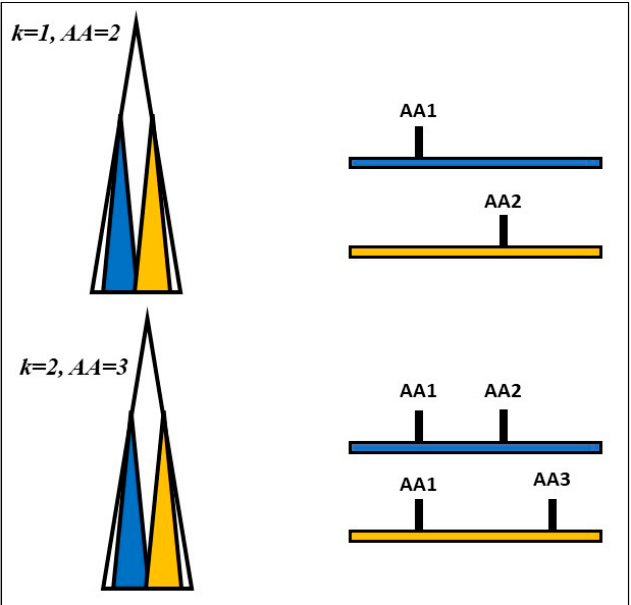
(Pept Oxoverlap ), whenever Σ AA > k. In such cases, for a peak with area P O A 1 (Figure A2).